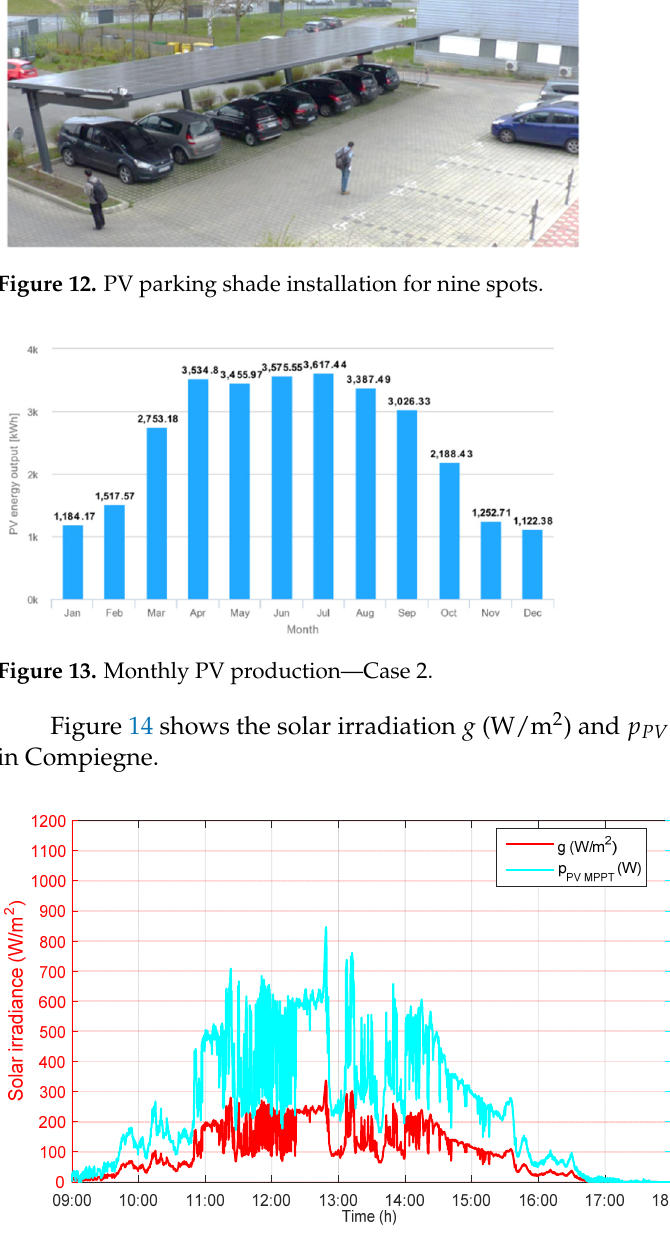
In conclusion, when the park time is known and long, PV benefits increase for the EV